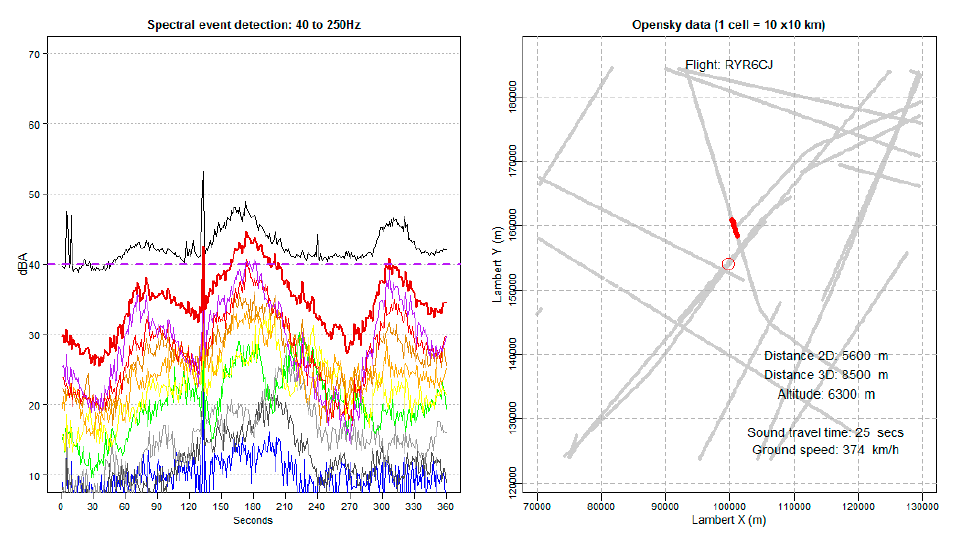
Figure 6. Noise time series with three consecutive events ( left ) and flight data ( right ) for the L LF,T,e window and the MP box . One event triggers the selected threshold. The sound arrival time window, matching the detector window L LF,T,w , is highlighted in the flight data. A lower threshold is capable of identifying each of the three events individually.